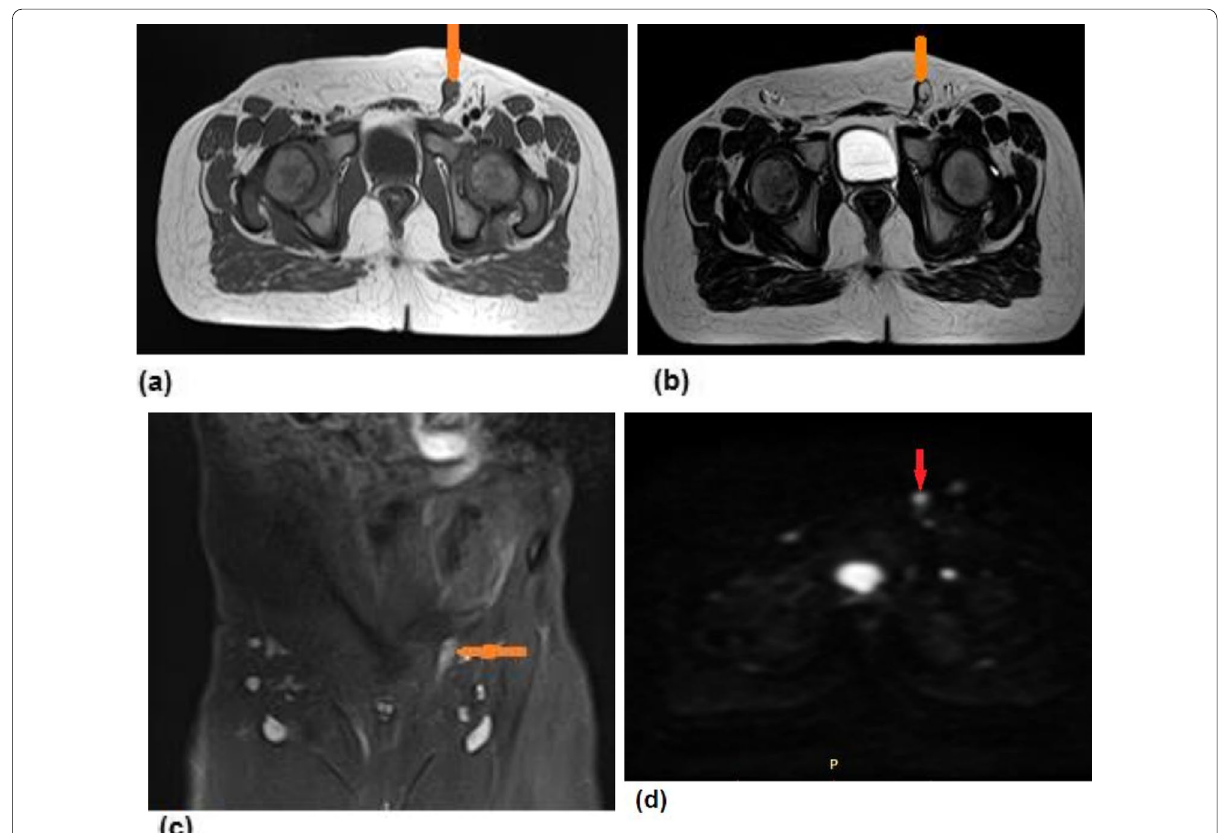
Fig. 3 A seven-year-old boy complaining of left non-palpable undescended testis since birth. MRI findings: a axial T1-weighted image, b axial T2-weighted image, c coronal STIR showing left undescended testes seen in the left inguinal canal at the internal ring measuring 9.88 it displays hypo-intense signal on T1W1, hyper-intense signal on T2W1 and hyper-intense signal on STIR. On DWIs : d axial diffusion-weighted image shows restricted diffusion at b value 800 s/mm 2 . Final diagnosis : left inguinal UDT. Surgical findings : laparoscopy confirmed the MRI findings, and = left orchiopexy was